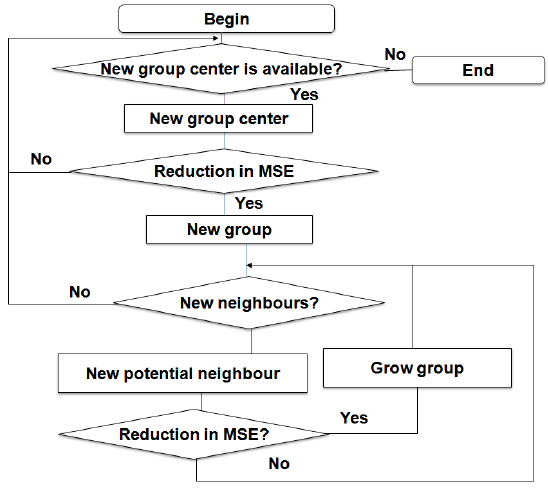
Figure 1. Algorithm flow